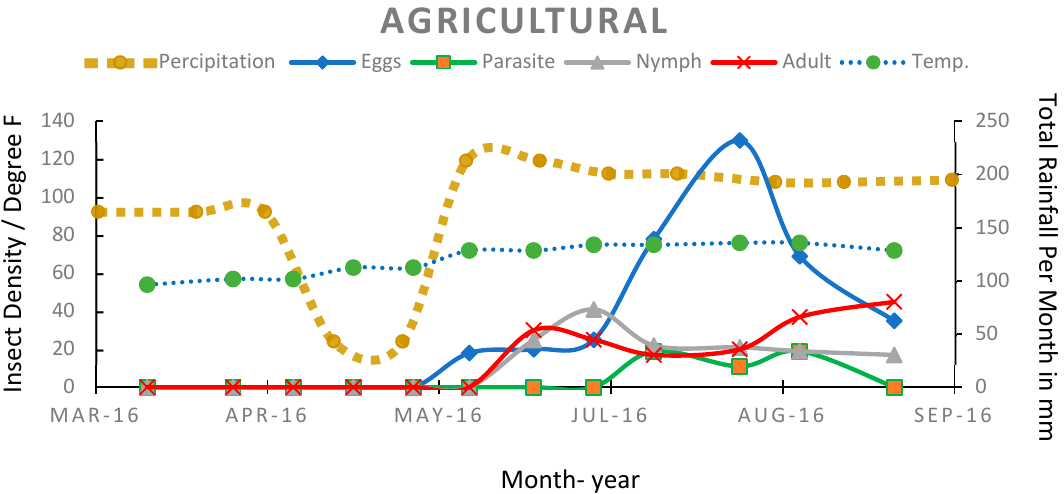
Figure 4. Population dynamics of M. cribraria and P. saccharalis for most active agricultural site in 2016. Host plant: soybean.